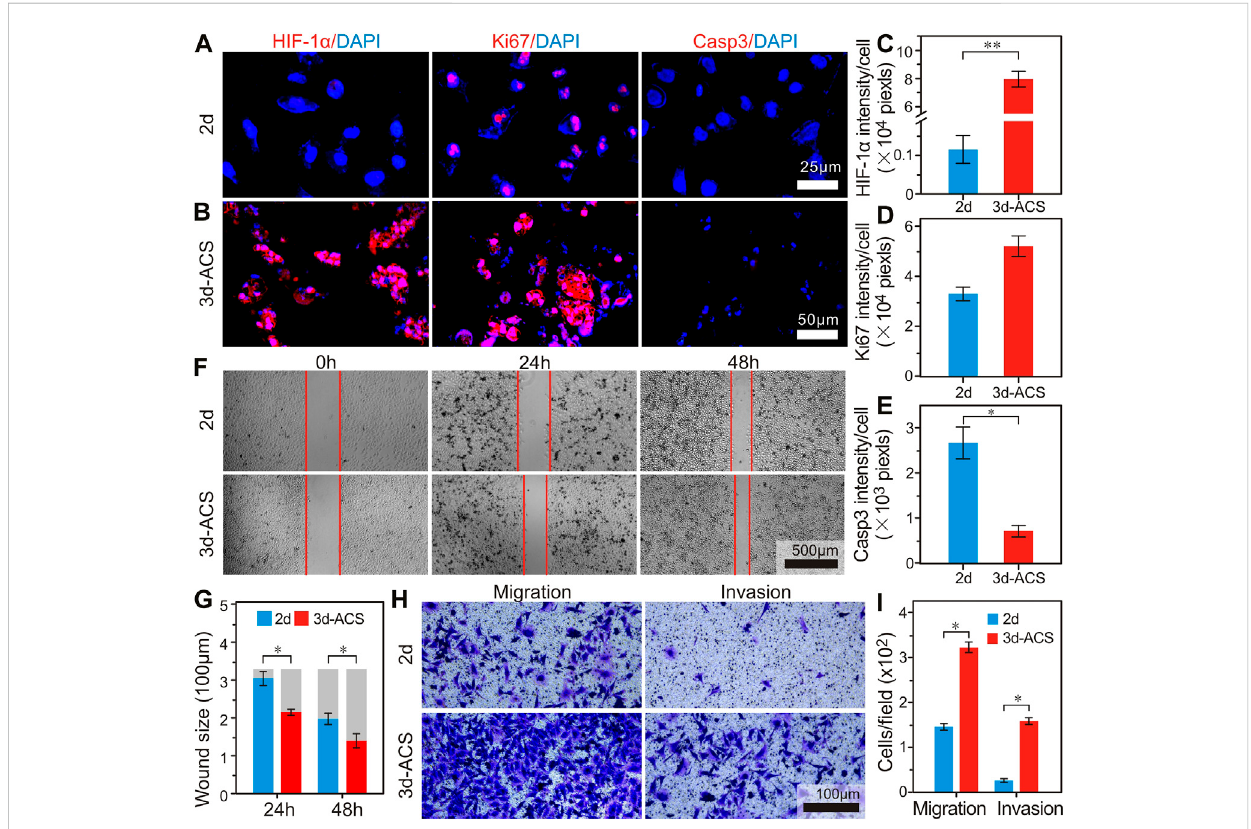
FIGURE 3 The biological characteristics changes of the GC cells in 3d-ACS and traditional 2d culture. (A,B) Immuno fl uorescence staining of HIF-1 α , Ki67, and Caspase3 in MGC-803 cells cultured in 2d petri dish and 3d-ACS. (C – E) Quantitative analysis of mean fl uorescence intensities of HIF-1 α , Ki67, and Caspase3 in2d culture and 3d-ACS. (F) Woundhealing experiments of monolayer MGC-803 cells released from 3d-ACS and 2d culture. (G) Quantitative results of wound healing experiments. (H) The transwell assay to evaluate the ability of migration and invasion of MGC-803 cells released from 3d- ACS and 2d culture. (I) Quantitative results of migration and invasion. n = 3 per group, *: p < 0.05, **: p <